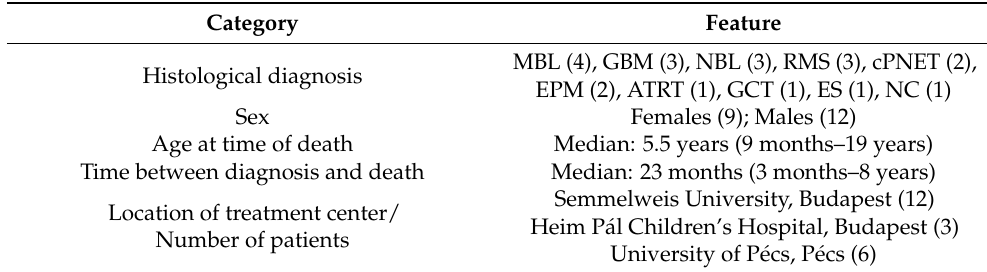
Table 1. Demographic and clinical characteristics of patients (n = 21). List of abbreviations: MBL: medulloblastoma; GBM: glioblastoma; NBL: neuroblastoma; RMS: rhabdomyosarcoma; cPNET: central primitive neuroectodermal tumor; EPM: ependymoma; ATRT: atypical teratoid rhabdoid tumor; GCT: germ cell tumor; ES: Ewing sarcoma; NC: NUT midline